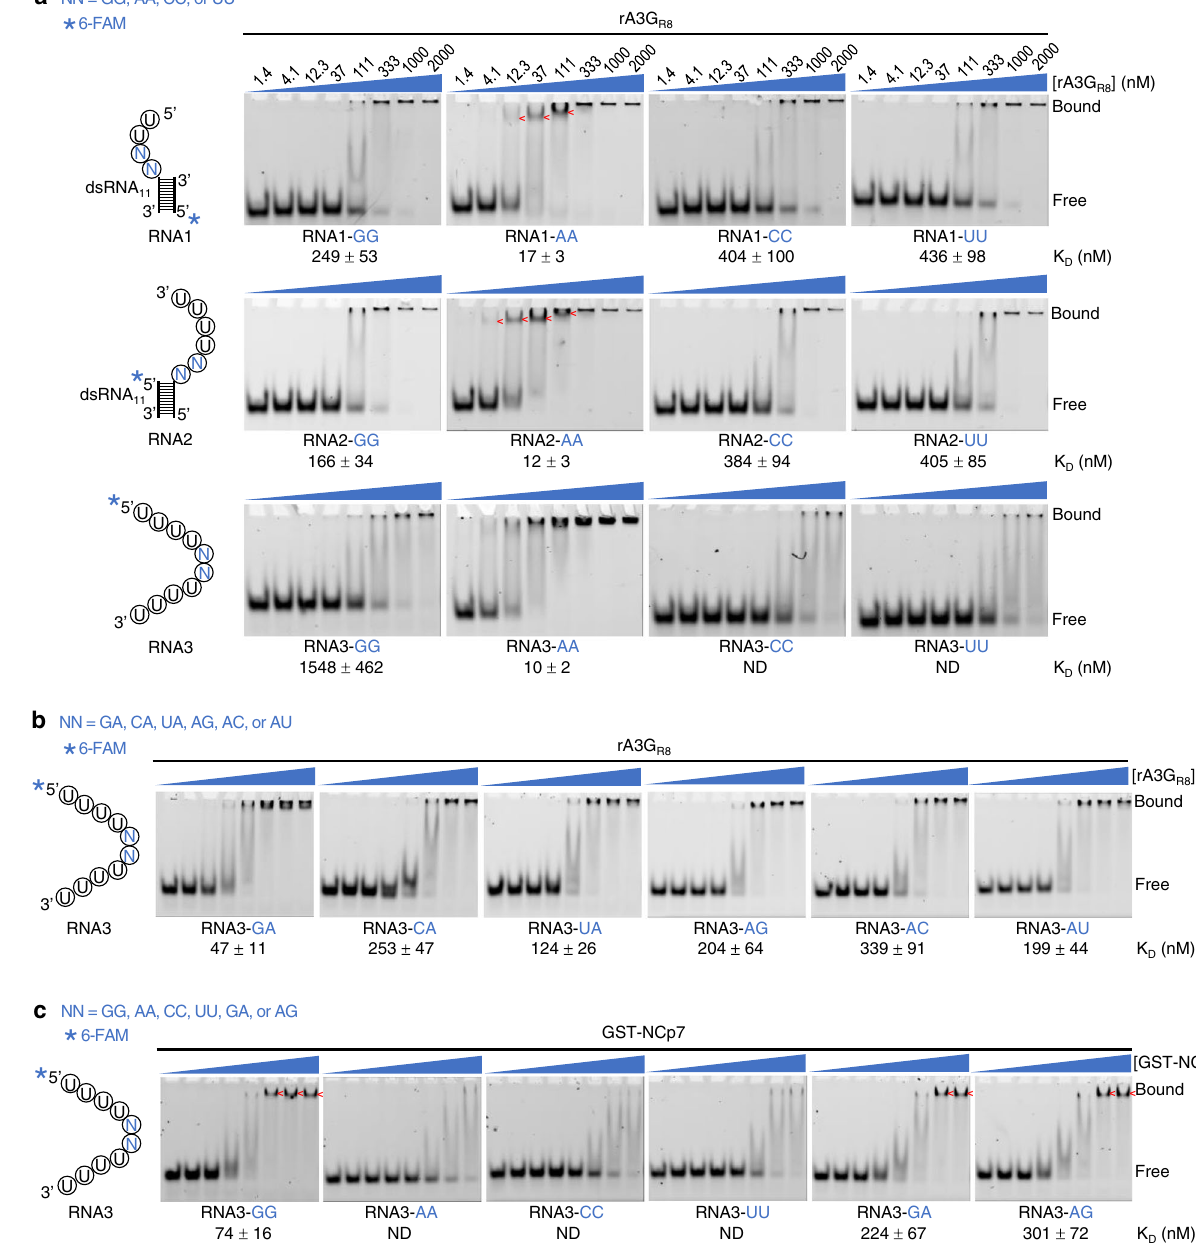
Fig. 1 | rA3G R8 and GST-NCp7 binding to various synthesized RNA molecules visualizedbyelectrophoreticmobilityshift assay(EMSA). a rA3G R8 binding to three types of RNA that contain two variable bases NN: 5 ′ overhang dsRNA (RNA1), 3 ′ overhang dsRNA (RNA2), and ssRNA (RNA3). NN= GG, AA, CC, or UU. dsRNA 11 represents an 11-bp double-stranded RNA molecule (Supple- mentary Table 1). b rA3G R8 binding to RNA3-NN, where NN =GA, CA, UA, AG, AC, or AU. c GST-NCp7 binding to RNA3-NN, where NN= GG, AA, CC, UU, GA,